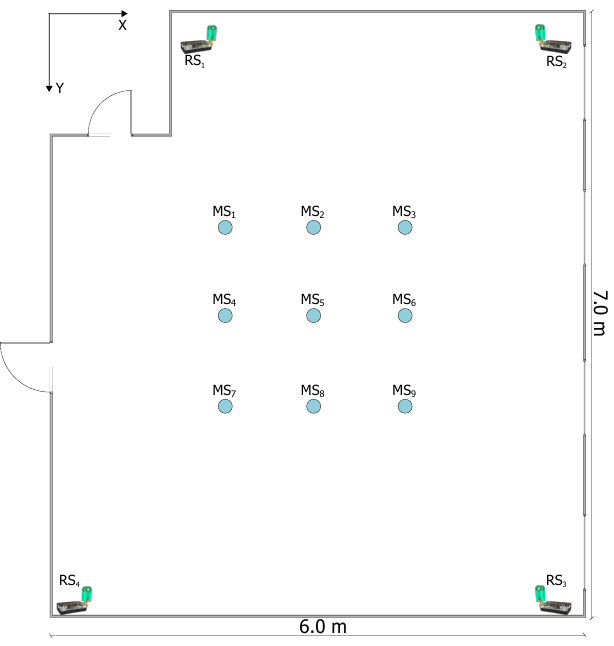
Figure 12. Experimental setup for position measures between various MSs and four reference